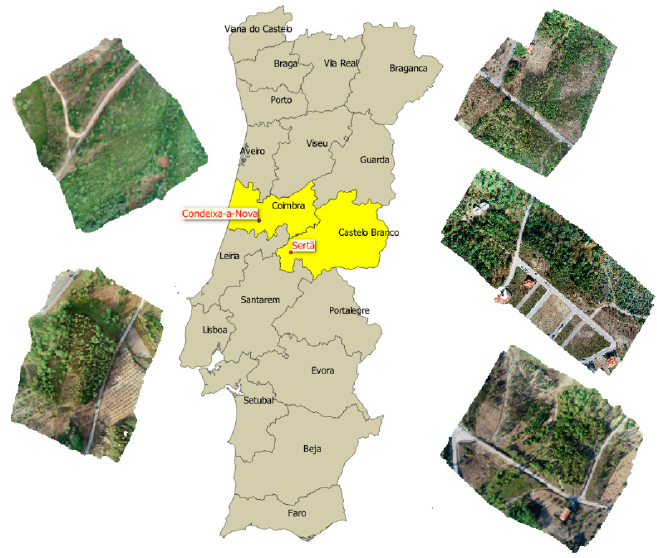
Figure 2. Five test sites in central Portugal—locations and RGB (visible color) representations (left: Condeixa-a-Nova sites; right: Sertã sites).